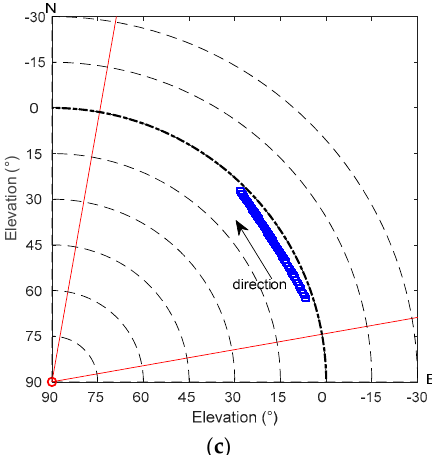
Figure 12. Examples of phase shift from two rainy days compared with radar reflectivity and path-averaged rain rate calculated from radar reflectivity: ( a ) on 27 June 2015; ( b ) on 10 August 2015; ( c ) sky plot of G22 at this selected time.